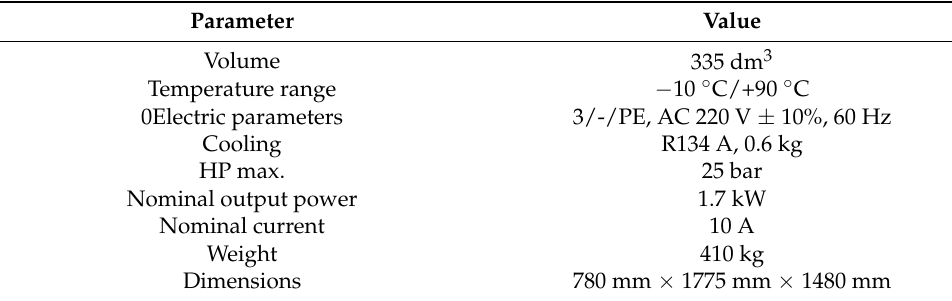
Table 2. Technical parameters of Climatic Chamber WK111